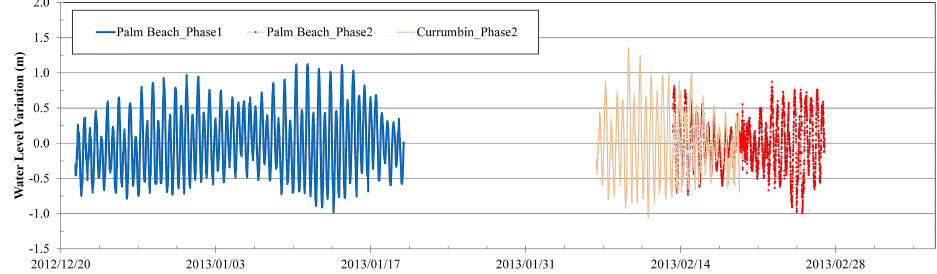
Fig. 2. Water level variations at the nearshore wave recording stations.